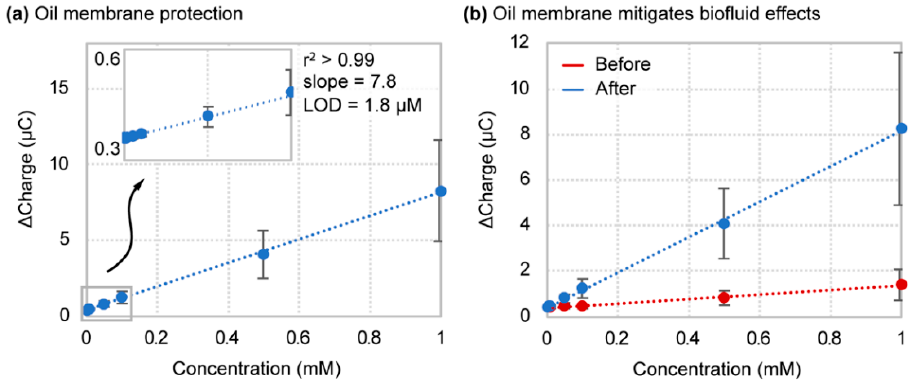
Figure 5. Hexacyanoferrate (II/III) titration and linear regression curves for ( a ) oil–membrane pro- tected boron-doped diamond. ( b ) A before-and-after comparison of oil–membrane implementation for the boron-doped diamond electrode.